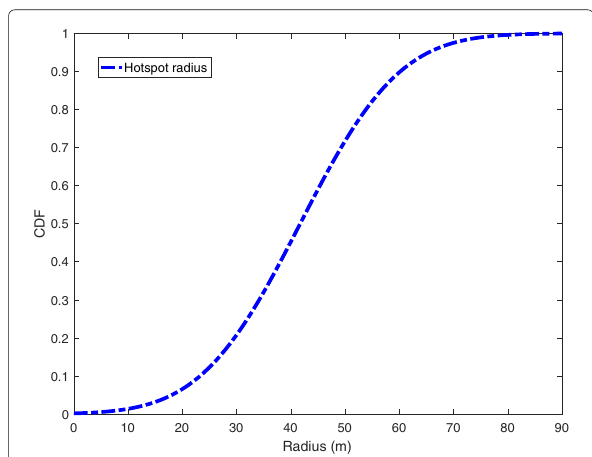
Fig. 9 Statistics on hotspots radius. This figure represents a CDF of the hotspots radius where 25% of the radius are below 32.7 m, half of the radius are below 39.4 m and 75% of the radius are below 50 m. A nearly Gaussian distribution for the cluster radius is observed which means that the closest value from the mean are more able to appear than the